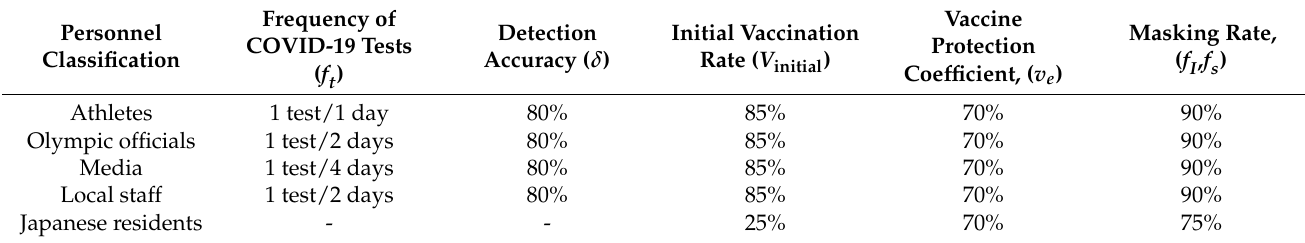
Table 4. The parameters used in the simulation for different roles of